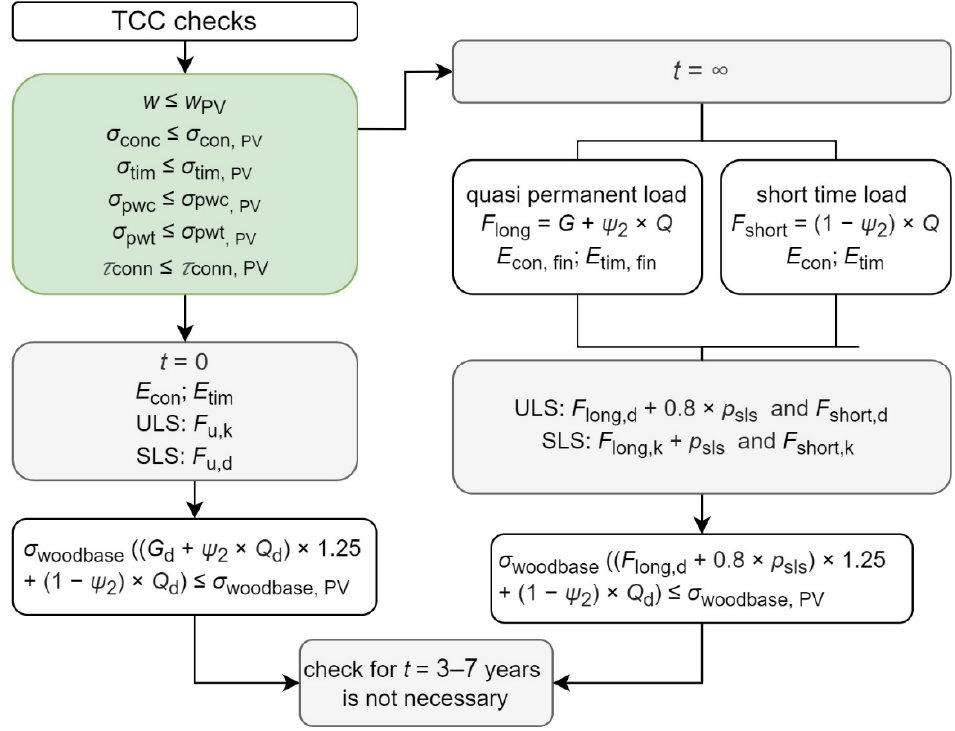
Figure 5. TCC checks with corresponding load combinations, where ULS and SLS are ultimate and